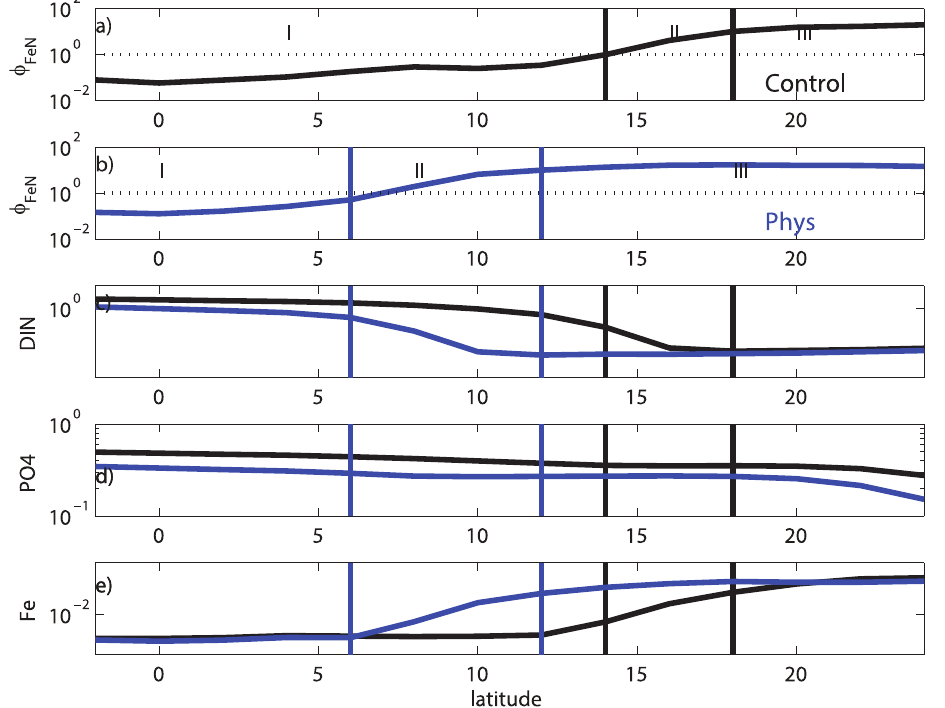
Figure 4. Model output from Pacific transect shown in Fig. 3. (a) φ FeN for control simulation; (b) φ FeN for Phys simulation with changes from a warming scenario at 2100; (c) DIN (mmolm − 3 ); (d) PO 4 (mmolm − 3 ); (e) iron (µmolm − 3 ). Vertical lines indicate province boundaries as determined only by presence or absence of diazotrophs, and limiting nutrient(s). Province are labeled (I, II, III). Black line indicate results from Control , and blue lines from Phys